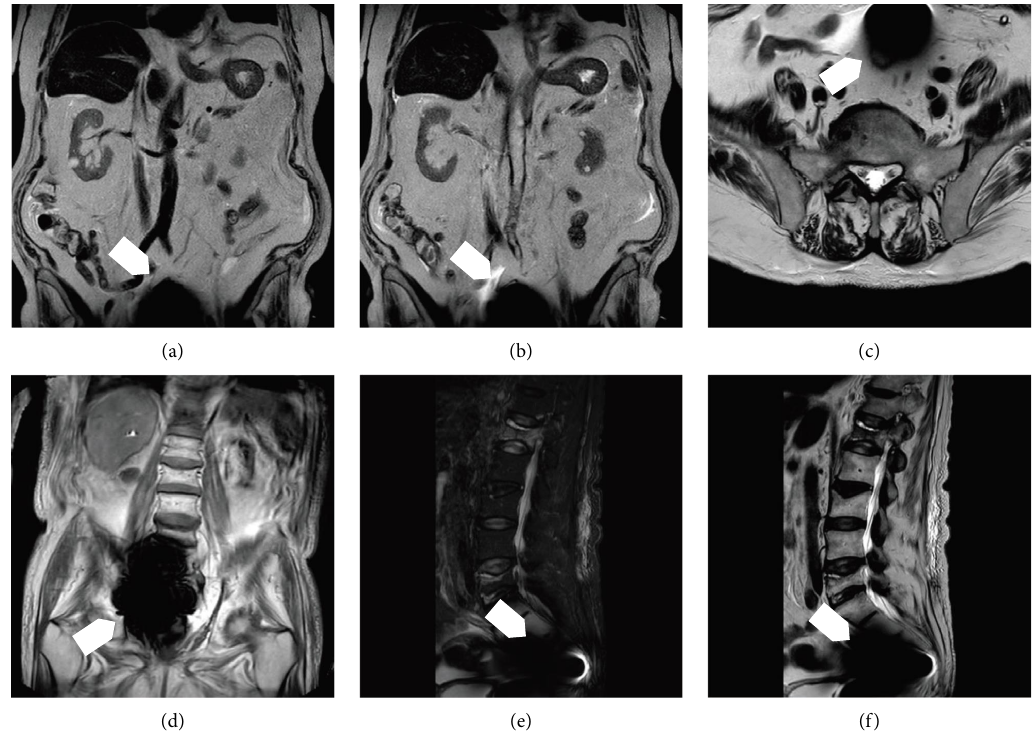
Figure 4: (a) Coronal fast-spin echo T1- and (b) T2-weighted images from an unenhanced abdominal MR study showing extensive paramagnetic “blooming” artifact at the lower end (arrow), corresponding to the site of the tip tungsten ballast. Axial T2- (c), coronal T1- (d), sagittal fat-suppressed (e), and T2- (f) weighted images performed to assess osteoporotic vertebral collapses show paramagnetic artifact (arrows) partially obscuring the anterior aspect of the